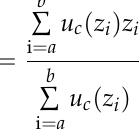
Figure 10. The surface of outputs. ( a ) The surface of '